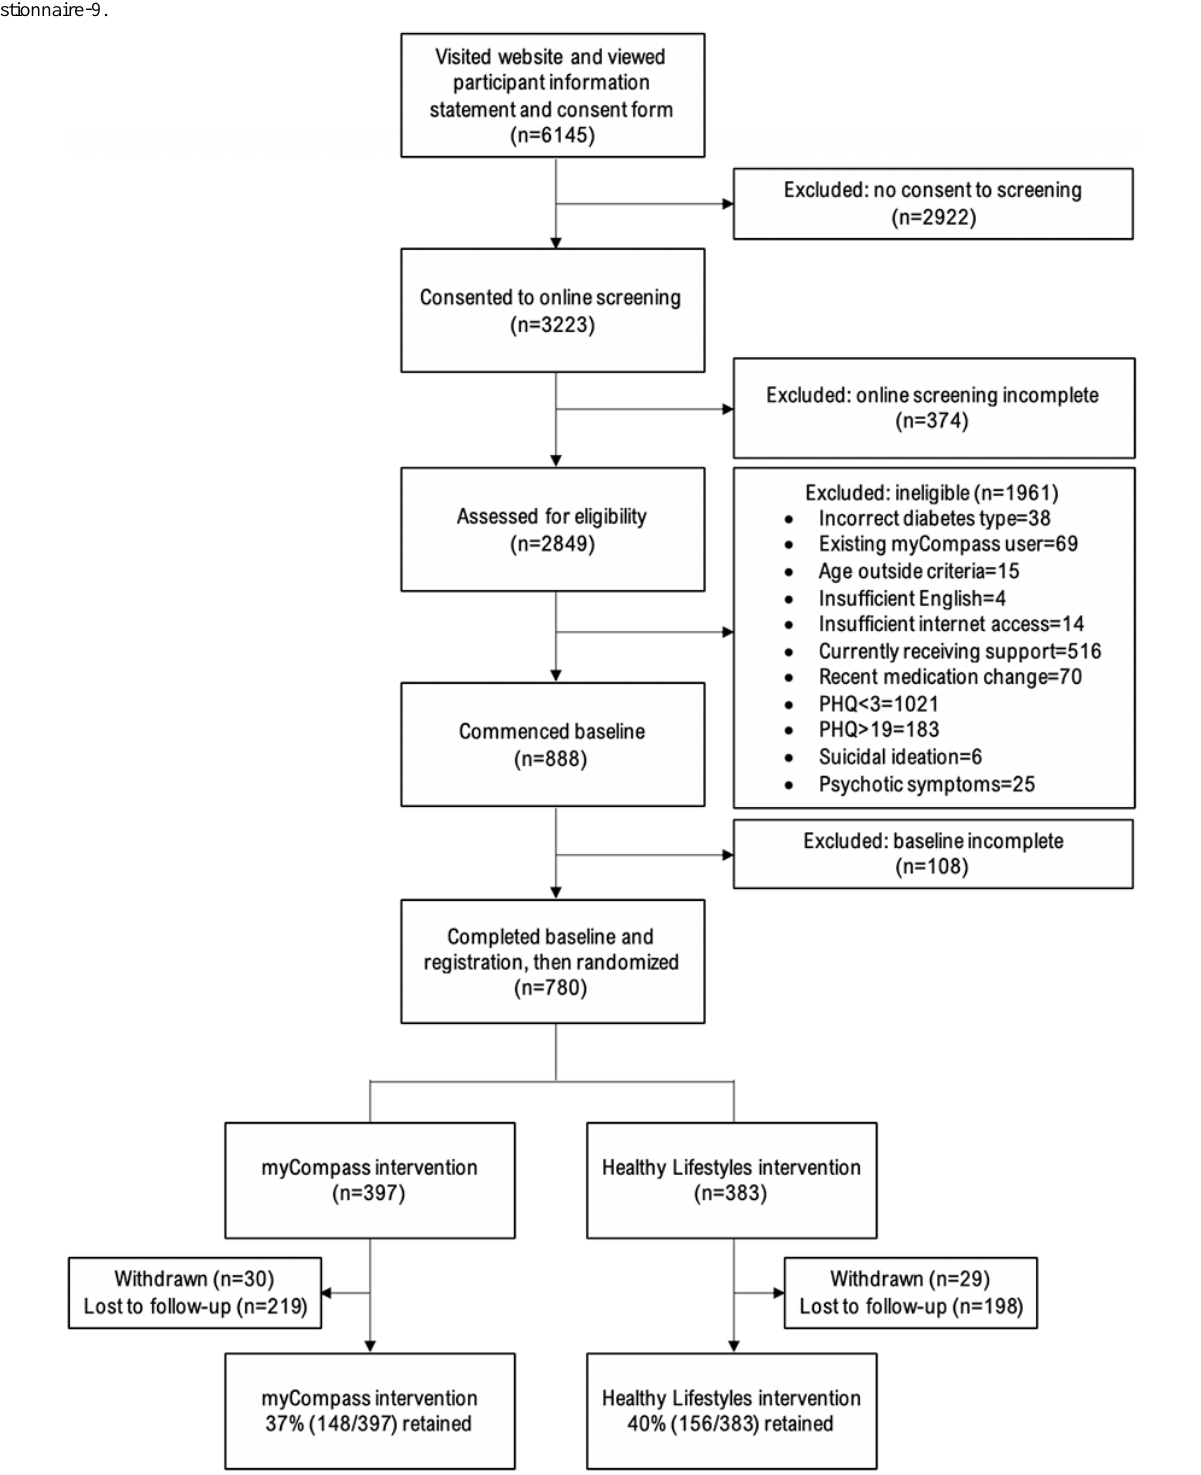
Figure 3. CONSORT (Consolidated Standards of Reporting Trials) participant flow diagram through the SpringboarD trial. PHQ: Patient Health